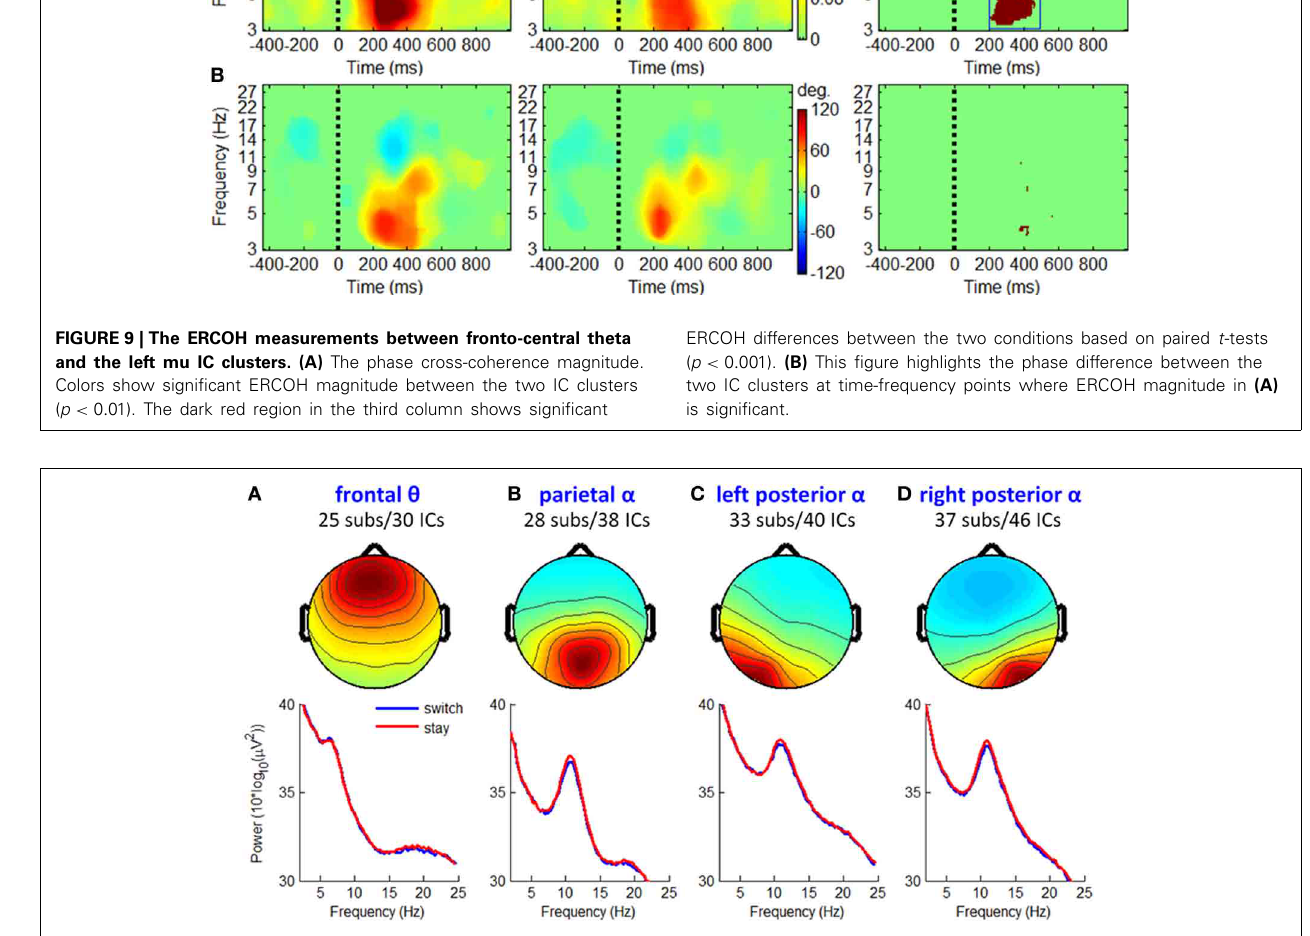
FIGURE 10 | Mean IC maps and power spectra of other four prominent IC clusters. (A) Frontal theta rhythm cluster. (B) Parietal alpha rhythm cluster. (C,D) Left and right posterior alpha rhythm